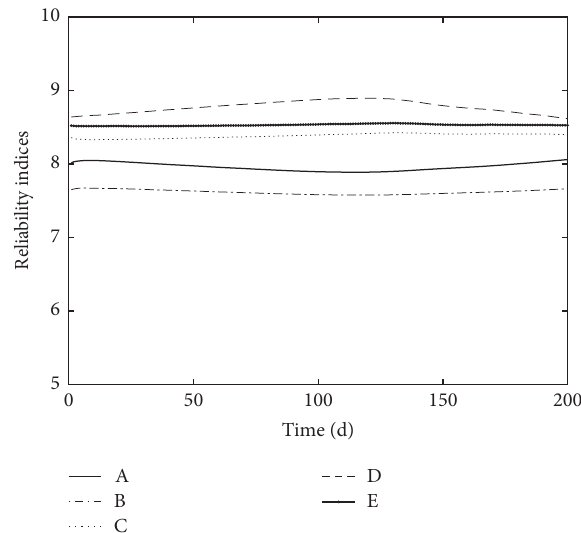
Figure 8: Comparative analysis of predicted reliability indices.